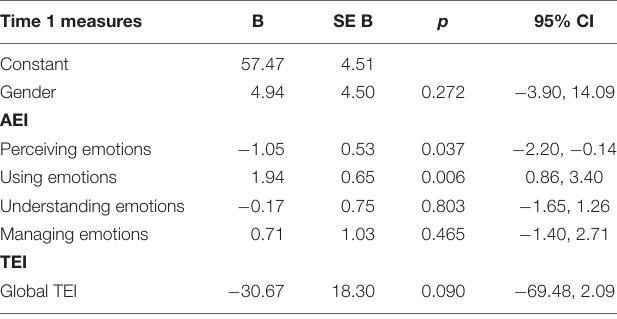
TABLE 2 | Bootstrapped regression analysis with AEI and TEI as predictors of prolonged depressive symptoms.